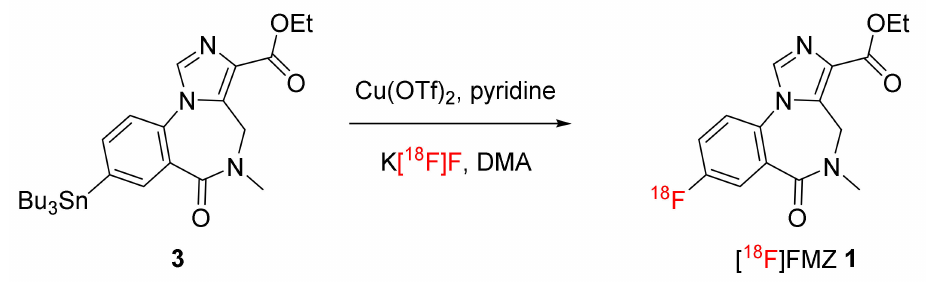
Figure 3. Cu-catalyzed radiosynthesis of [ 18 F]FMZ 1